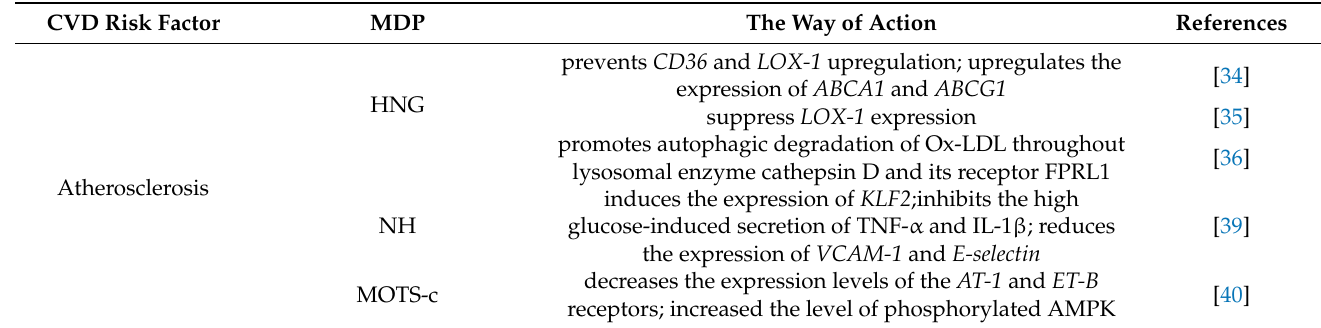
Table 1. Identified connections between MDPs and CVD risk